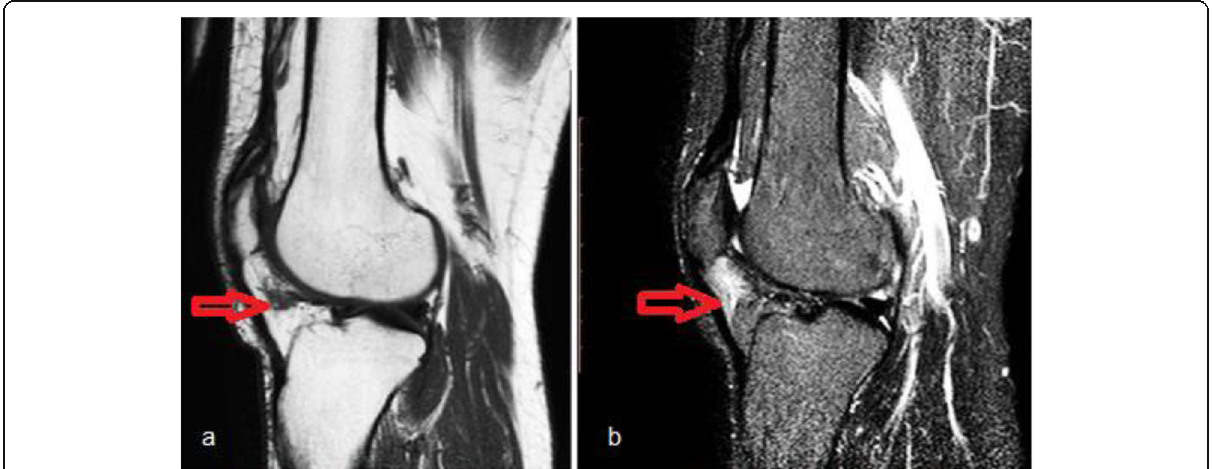
Fig. 9 a , b MRI images for infrapatellar fat pad impingement syndrome. a Sagittal T1WI and b sagittal PD fat suppression images demonstrated edema involving a significant portion of the infrapatellar fat pad (red open